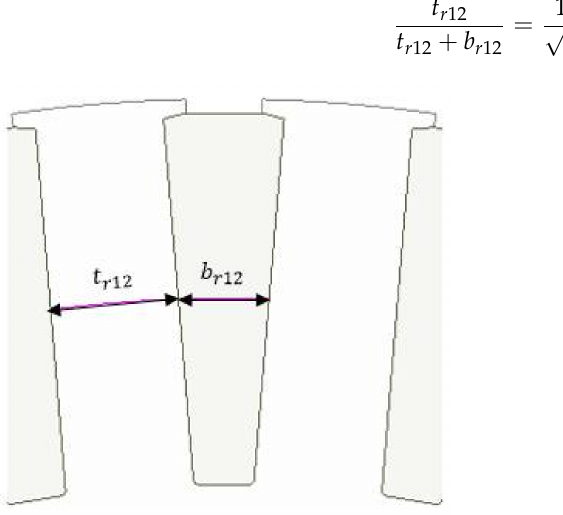
Figure 22. Rotor